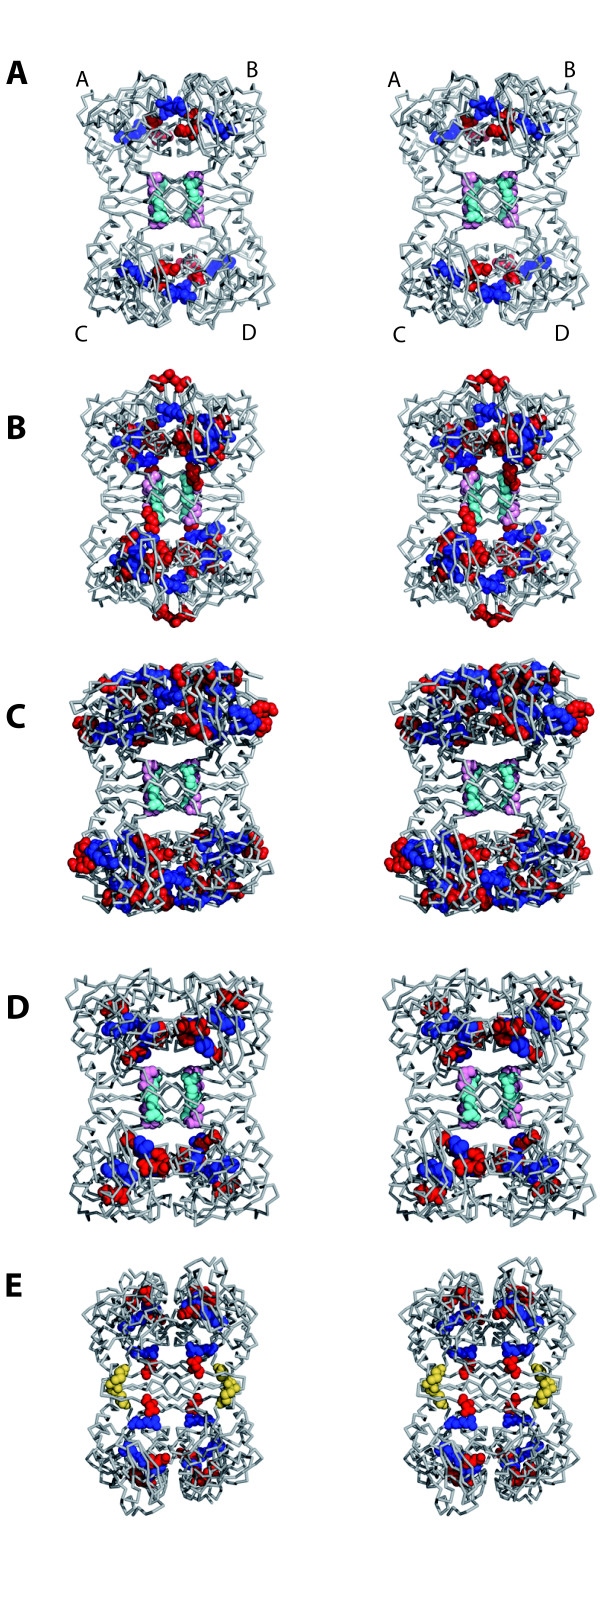
Stereo views highlighting the regions interacting across the dimeric and tetrameric interface. The dimeric interfaces are between dimers AB and CD, and the tetrameric interfacebetween dimers AC et BD. Residues involved in ionic interactions at the A/B dimer interface are shown in red or blue spheres (for acidic or basic residues, respectively). Glu226 and Arg230, which form a salt bridge involved in the tetrameric assembly are shown in pink and cyan spheres, respectively. Inter-monomer disulfide bridges between cysteines 196 and 233 in PaTrmI are shown in yellow. A MtTrmI, B TtTrmI, C TmTrmI, D AaTrmI, E PaTrmI.